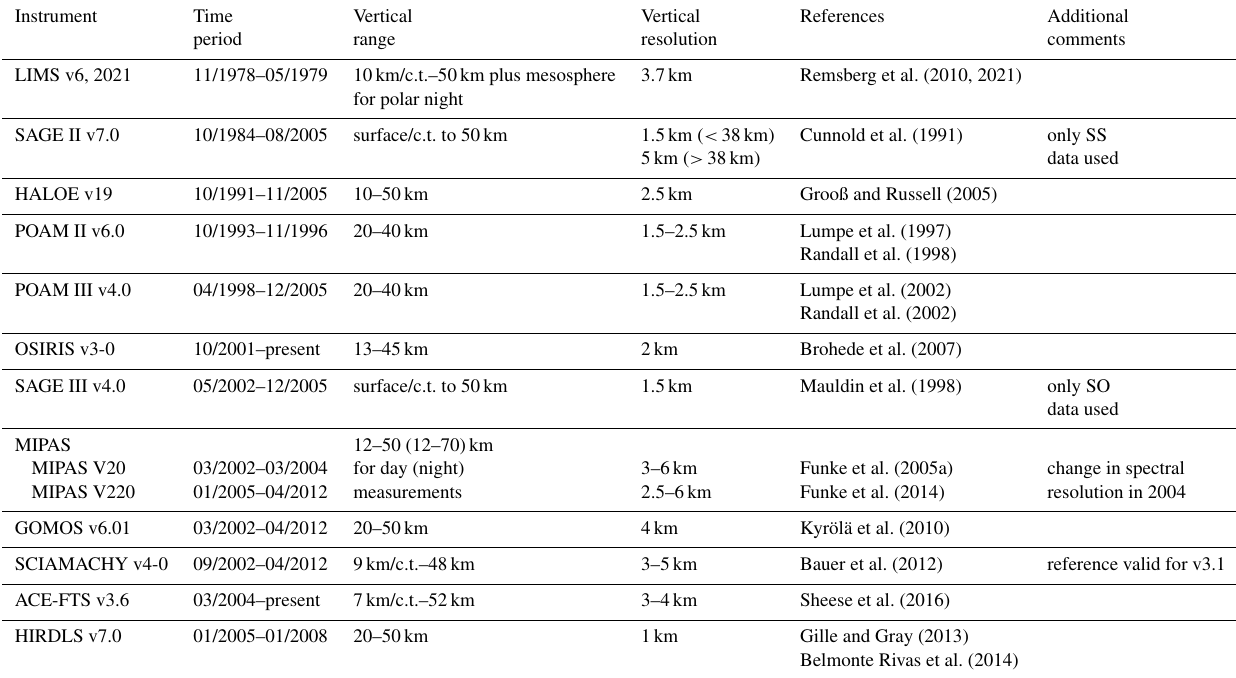
Table 14. Time period, vertical range, vertical resolution, references, and other comments for NO 2 measurements. Note that c.t. refers to cloud top in this